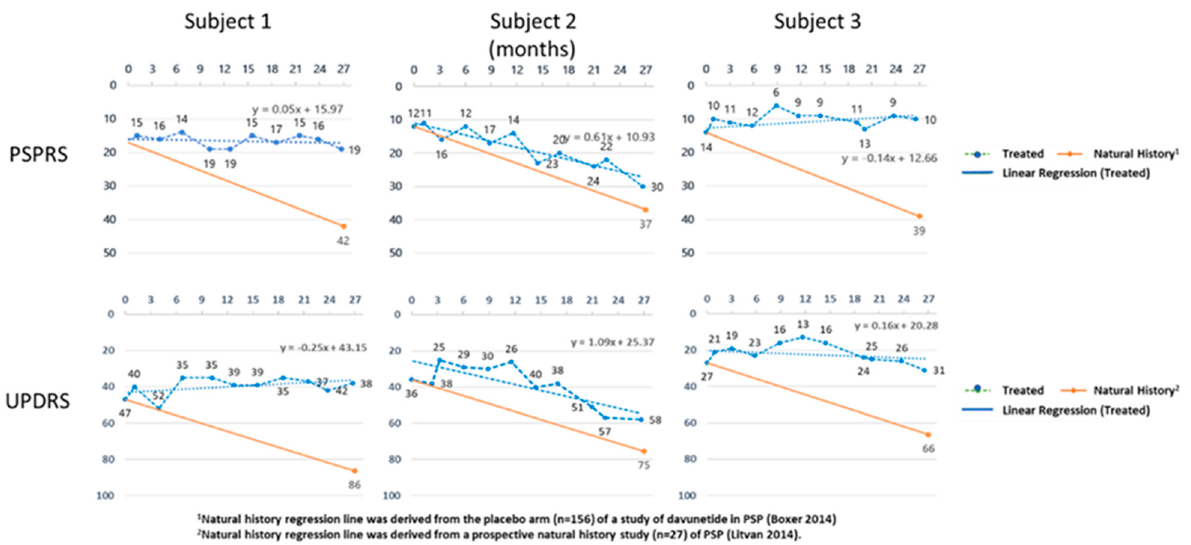
Figure 3. The PSPRS and UPDRS scores for the three subjects are shown over time. The orange line indicates the expected change in scores based on historical control subjects obtained from the placebo arm of a clinical trial in PSP patients for the PSPRS [22], and in a natural history study of PSP for the UPDRS [23].